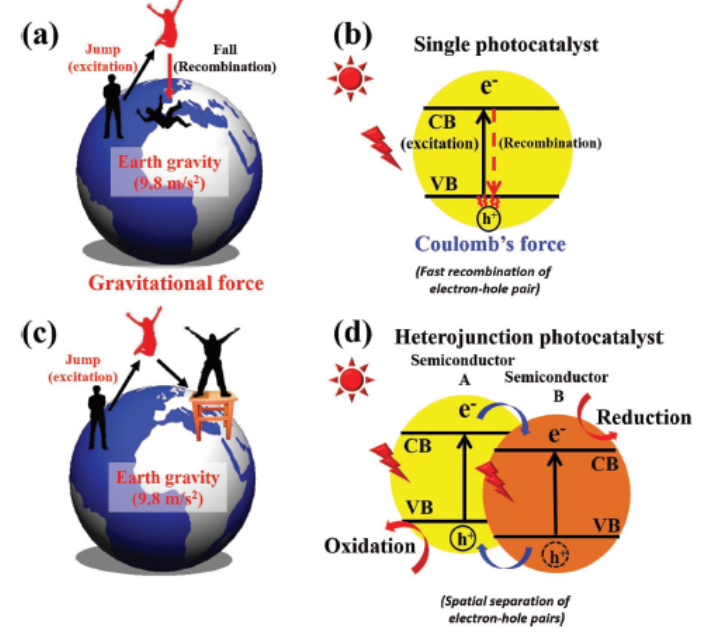
Figure 18. Heterojunction scheme ( a ) Fall back to the surface due to gravitational force, ( b ) recombination electron due to Coulomb force, ( c ) additional bench prevents to fall back in surface, ( d ) additional conduction band prevents to electron recombination [79]. Reproduced with permission from Low et al. Copyright © 2022 John Wiley & Sons, Inc.